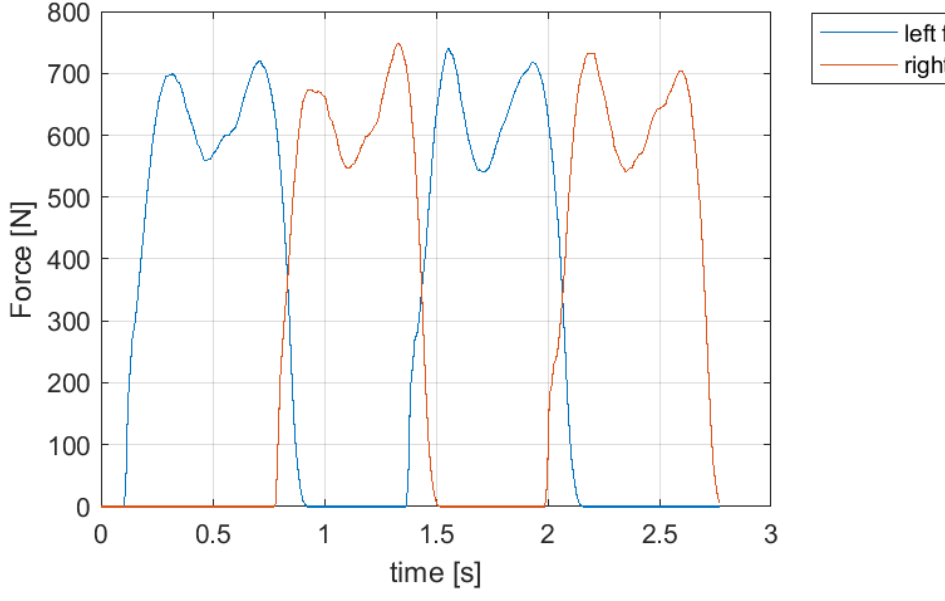
Figure 4. Vertical ground reaction force (vGRF) for left and right foot calculated from a pressure plate for gait event extraction. Green vertical lines show the extracted initial contact (IC) events, in black, toe-off events (TO).